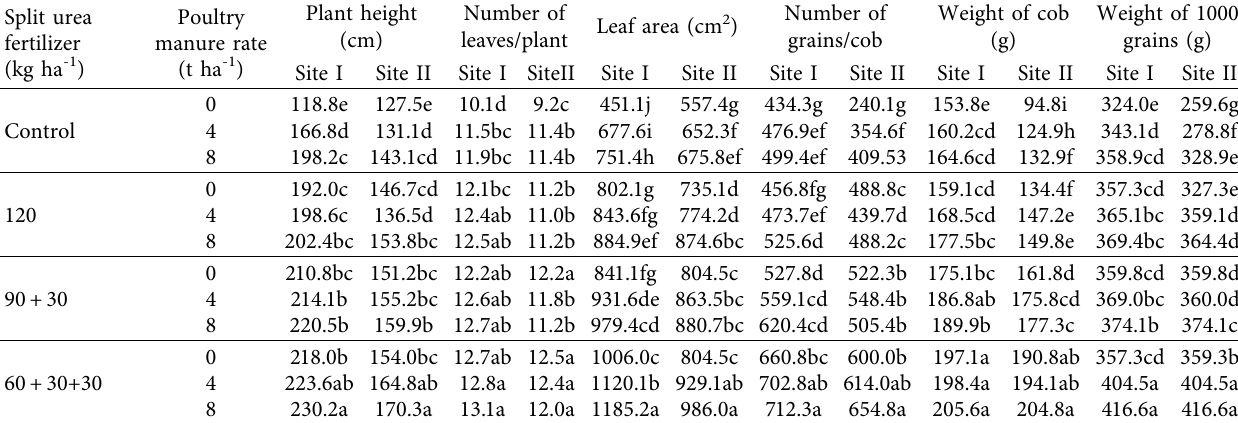
Table 3: Effects of poultry manure and split urea fertilizer on growth and yield of